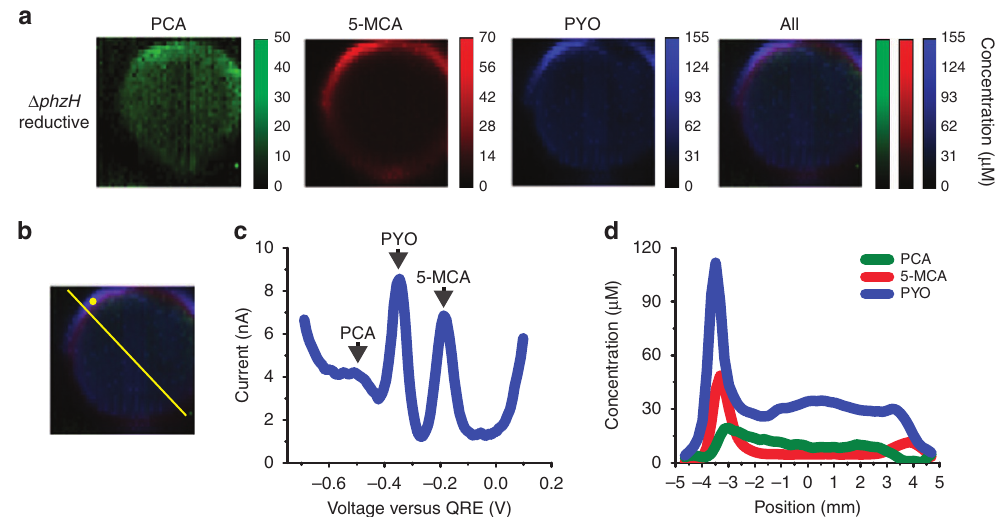
Figure 5 | Electrochemical imaging of a D phzH biofilm. ( a ) Electrochemical imaging, based on reductive SWV, of a D phzH biofilm after 2 days of development. Pixel intensity is proportional to phenazine concentration. PCA is shown in green, 5-MCA in red and PYO in blue. Maximum error due to electrode variability is 18 m M for PCA, 8 m M for 5-MCA and 14 m M for PYO. Images are 8mm (cid:2) 8mm. ( b ) Locations of example square-wave voltammogram and cross-section in c , d , respectively. ( c ) Example square-wave voltammogram from a single electrode. ( d ) Example cross-section from the electrochemical image in a